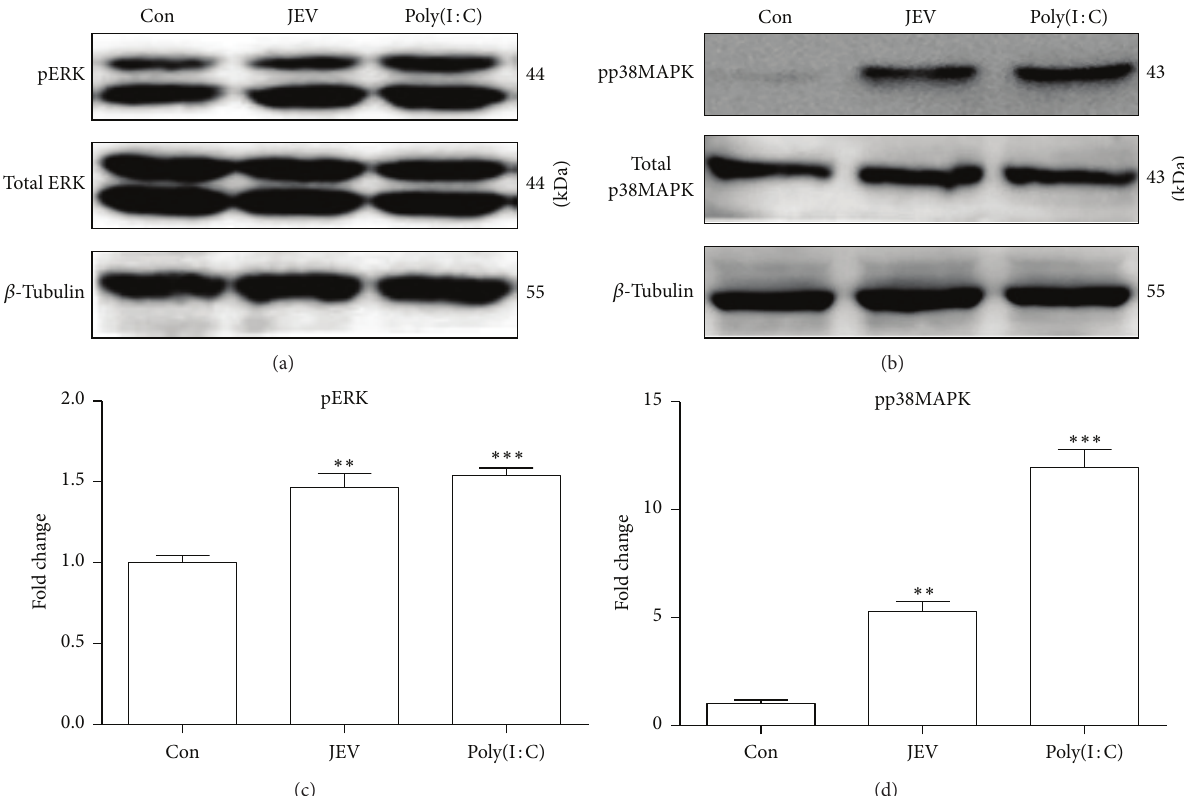
Figure 2: Activation of ERK and p38MAPK by JEV infection in BV-2 cells. BV-2 cells were either mock infected or infected with JEV at an MOI of 1. Poly(I:C) was added as a positive control. At 5 hpi, western blotting was performed to detect the phosphorylation of ERK (pERK) (a) and p38MAPK (pp38MAPK) (b). The protein levels were quantified with immunoblot scanning and normalized to the amount of 𝛽 -tubulin (c and d). Error bars represent the standard deviation of results from three independent assays ( ∗∗ 𝑃 < 0.01 ; ∗∗∗ 𝑃 < 0.001